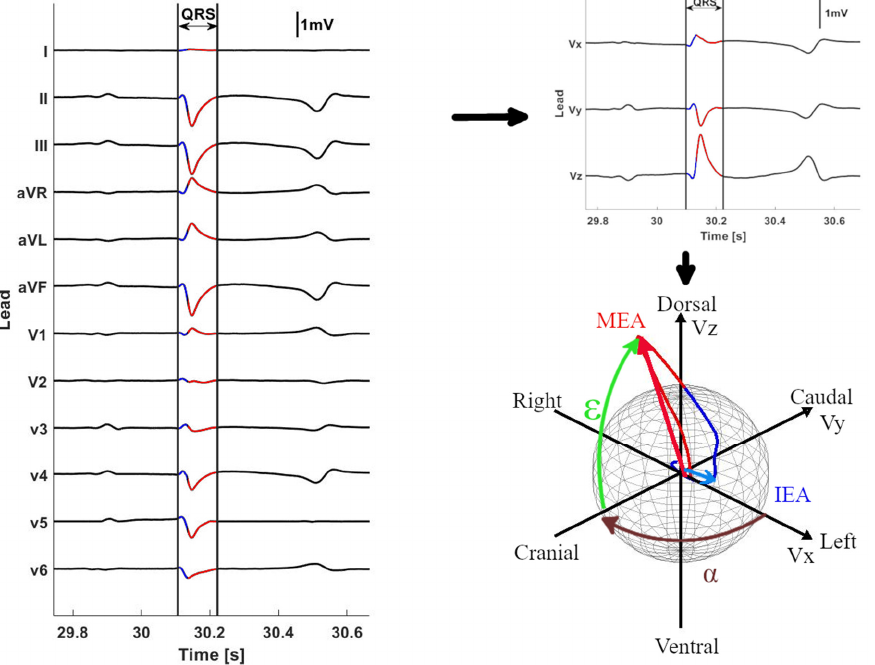
Figure 2. Example of the analysis of a QRS complex originating from the right ventricular outflow tract. First, the QRS complex (red) was manually identified on the 12-lead ECG; after which, the initial QRS signal (blue) was automatically selected within the first 40 ms after onset. After selecting the QRS complex, the VCG axes were derived from the 12-lead ECG with Vx right–left, Vy cranial–caudal and Vz ventral–dorsal. Next, the spherical coordinates were calculated from the VCG. If a local maximum could be found within the first 40 ms, this was selected as the initial electrical axis (IEA), but if no local maximum could be found, the IEA was defined as the coordinates with the largest radius within the first 40 ms. The maximum (MEA) electrical axis was automatically defined as the coordinates with the largest radius within entire duration of the QRS complex. The IEA and MEA are shown by the blue and red arrows on the sphere, respectively. For each electrical axis, the azimuth ( α ) and elevation ( ε ) were calculated as shown on the sphere. The intersection of the sphere and the electrical axis is projected on the Lambert azimuthal equal-area plots of Figures 3 and 4.